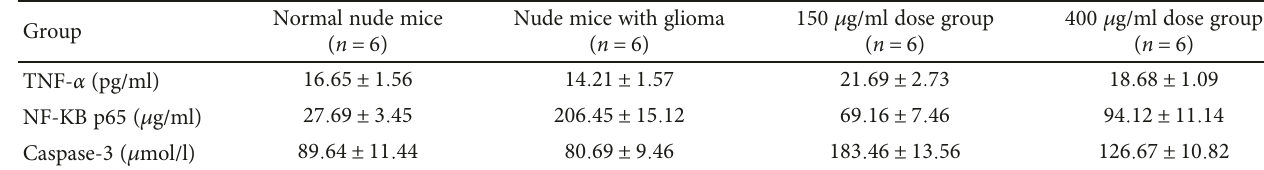
Table 2: E ff ect of radix hedysari polysaccharide on the TNF- α signaling pathway in nude mice with glioma.